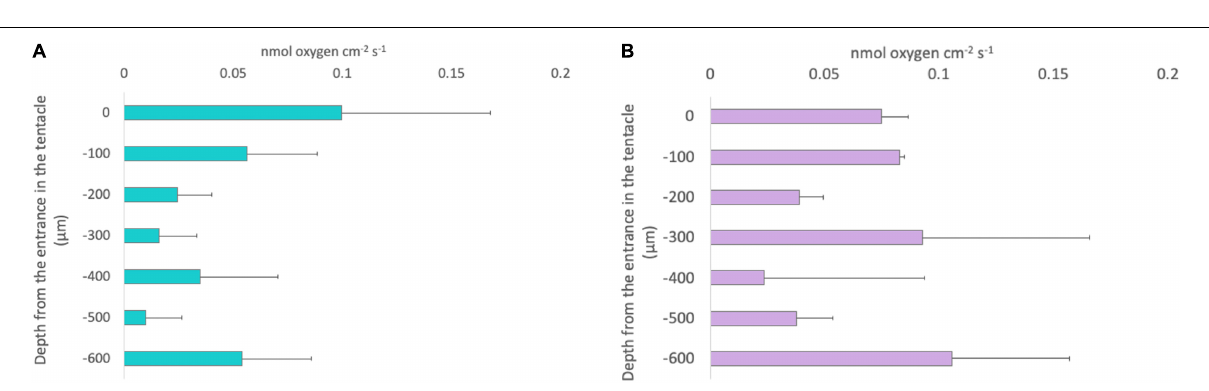
FIGURE 5 | Depth profiles of gross photosynthesis in nmol cm − 2 s − 1 in Cassiopea sp. oral arms measured using the light-dark shift method. Each bar represents the gross photosynthesis measured at that specific depth within the oral arms. (A) Turquoise bars: the values of gross photosynthesis obtained form specimens collected during the afternoon. (B) Lilac bars: the values obtained from specimens collected at sunrise. Depth profiles are not significantly different between the two conditions (LMMs, Compound Symmetry, Numerator df = 1, Denominator df = 4, F = 30.897, p -value = 0.171; n = 3). Error bars represent the extreme